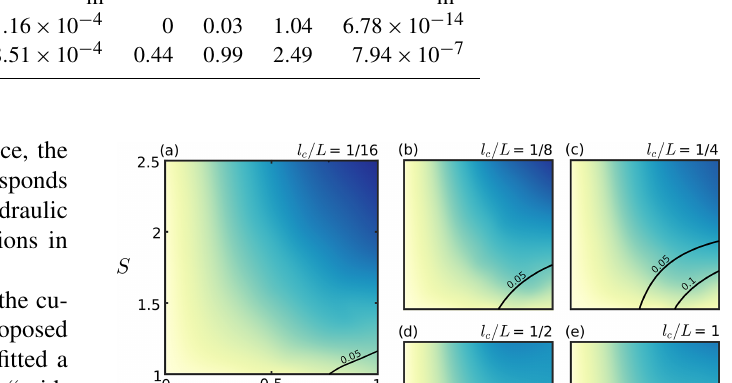
r g1 = 100 ; r g2 = 20 . Table 2. Resulting minimal and maximal values for mean aperture ( a ), standard deviation of the aperture field ( σ a ), contact fraction ( c ), relative fracture closure ( R ), effective surface area ( S ), and numerical fracture permeability ( k m ) for the fracture geometries in group 2. Parameter a σ a c R